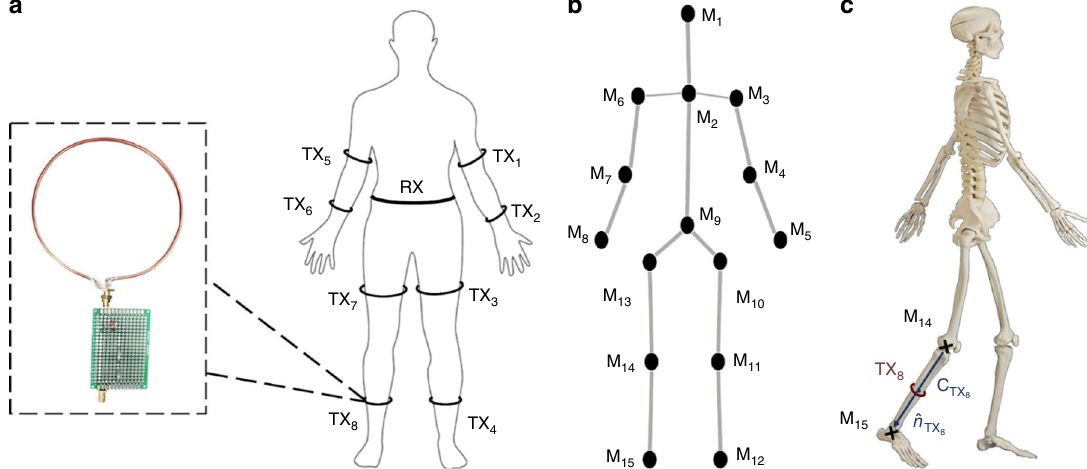
Fig. 8 Magnetic induction (MI)-based communication system. a Location of MI transceivers (TX i , RX) on the human body and the laboratory version of an MI transceiver. b Location of markers (M j ) on the body. The marker pairs of (2,9), (3,4), (4,5), (10,11), (11,12), (6,7), (7,8), (13,14), (14,15) de fi ne two ends of the torso, left arm, left hand, left thigh, left leg, right arm, right hand, right thigh, and right leg, respectively. Consequently, these pairs can be utilized to calculate the location of coils ( C , C RX ) and their alignment ( b n , b n ). c The center and alignment of a bone and its corresponding coil can be TX i TX i RX calculated using markers Simulation . Figure 8a depicts the location of coils considered around the human body for generating synthetic MI motion data. The location of markers required to